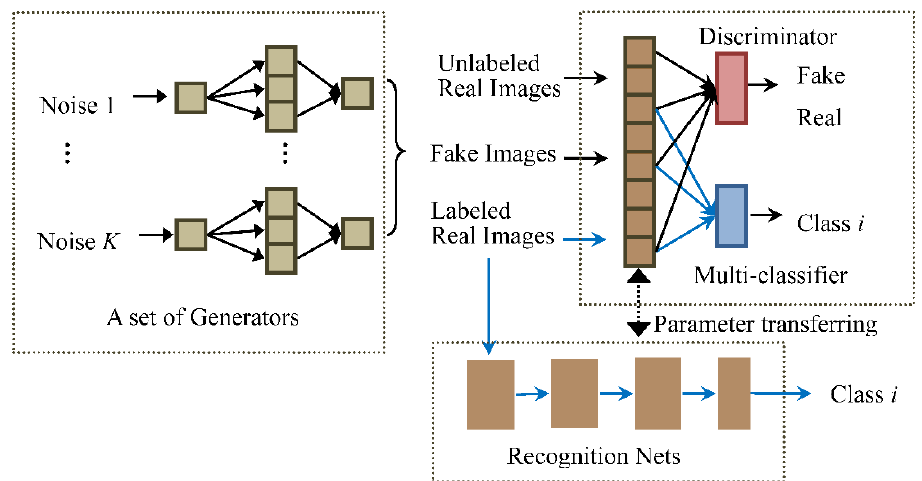
Figure 1. Architecture of our semi-supervised MCGAN and MCGAN-based recognition networks.